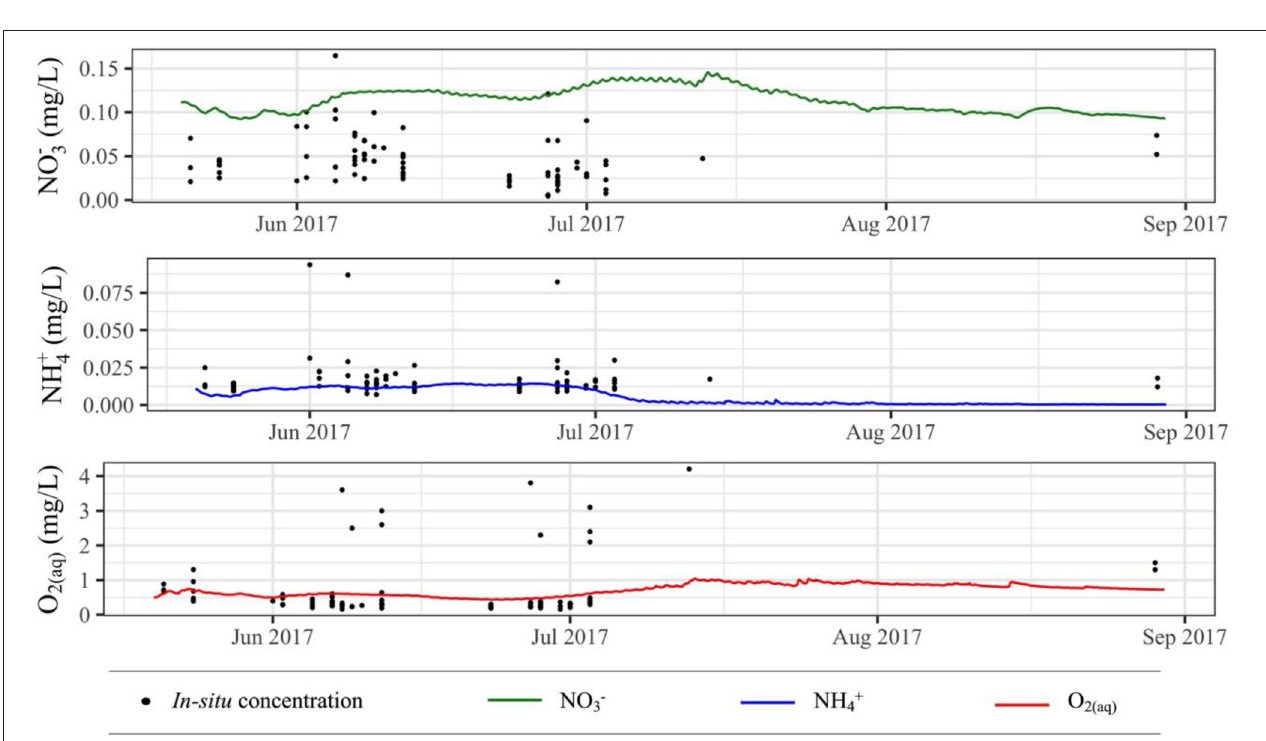
FIGURE 8 | Simulated aqueous species concentrations compared to in situ aqueous species concentrations; multiple y-values for a single x-value represent in situ measurements at multiple locations and/or depths on a given day.